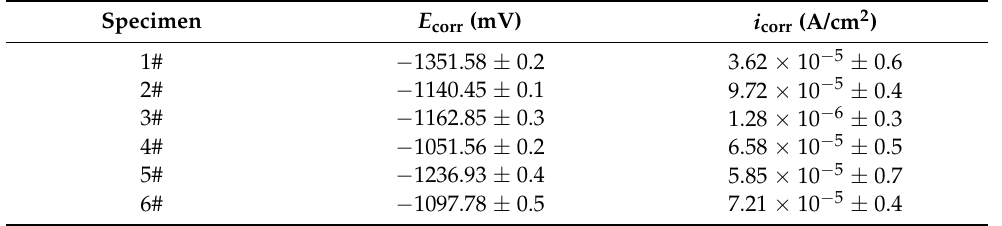
Figure 2. Polarization curves of six groups of aluminum-based anodes. Table 2. Corrosion parameters obtained from potentiodynamic polarization for different aluminum alloys.